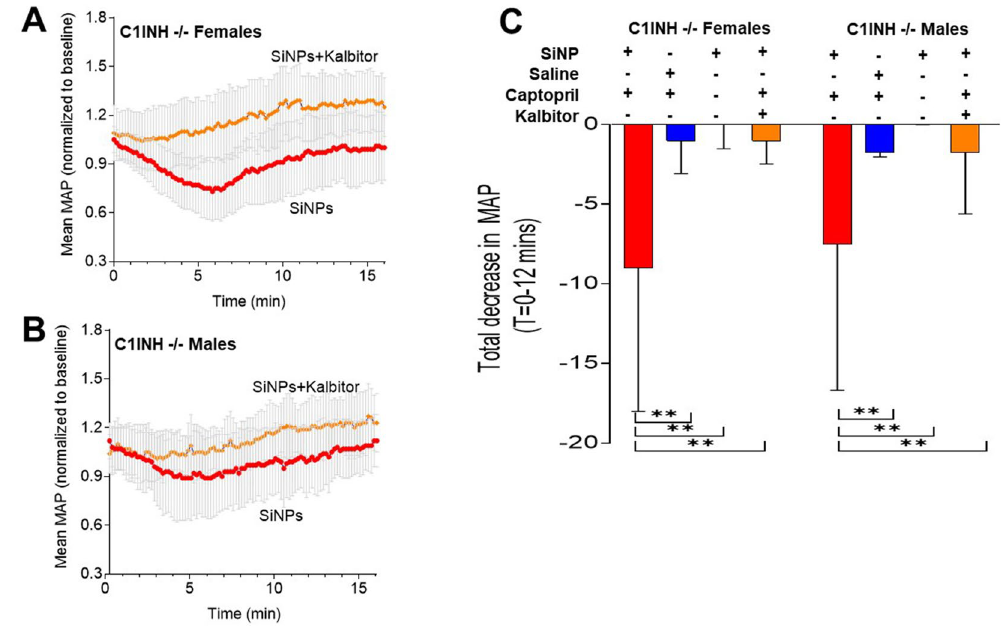
Figure 2. Ecallantide (Kalbitor) ameliorates the SiNP-induced MAP decrease in captopril-treated Serping1−/− mice. ( A , B ) Kalbitor (100 µg), injected immediately prior to a bolus IV injection of SiNPs (0.25 mg/100 µl) at t = 0, inhibits the SiNP-induced decrease in mean MAP in both ( A ) serping1−/− females (n = 9) and ( B ) serping1−/− males (n = 9). ( C ) The histogram compares the total decrease in MAP (t = 0—12 min) in serping1−/− female and serping1−/− male mice as per the Materials and Methods, with four different interventions. Data are expressed as mean ± SD. Statistical analysis was performed using 2-way ANOVA